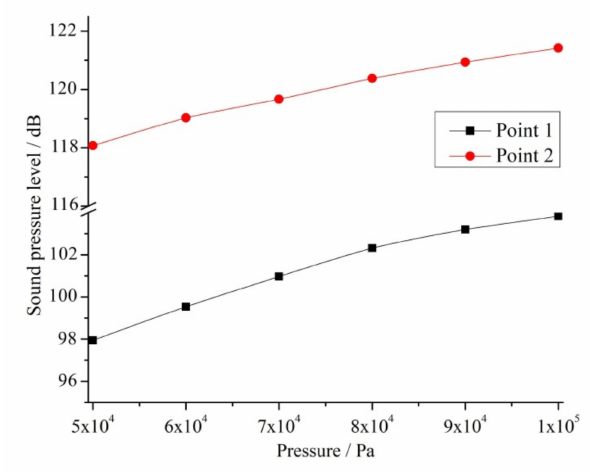
Figure 12. Fan noise under negative